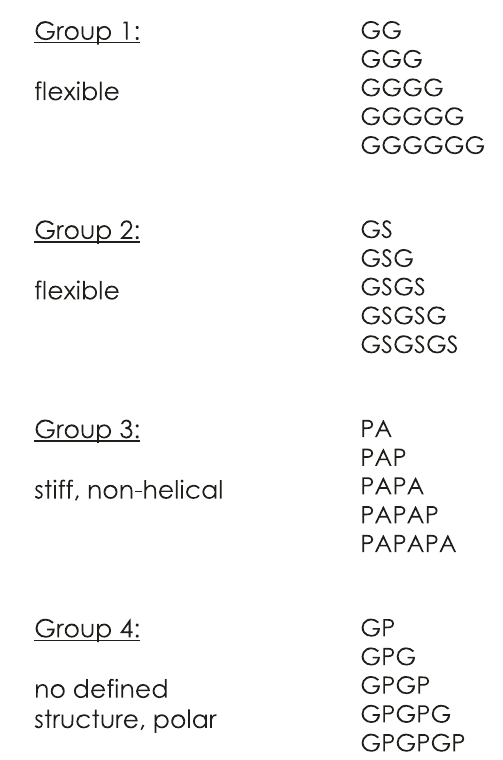
Fig. 4 The insertion sets of the LILI library. The four sets of applied linkers as insertions after V257, F278, and Q286 for the LILI library. Group 1 and 2 represent very fl exible, polar linkers. Group 3 is known as stiff and non- helical linkers. Group 4 insertions are polar and show no distinct